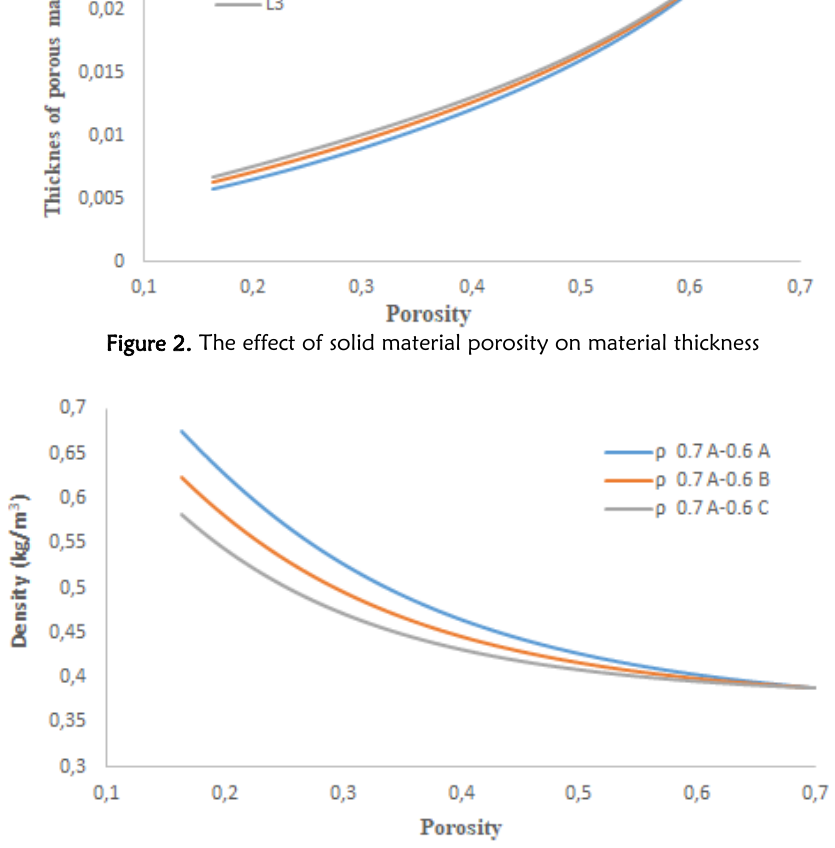
Figure 3. The effect of solid material porosity on